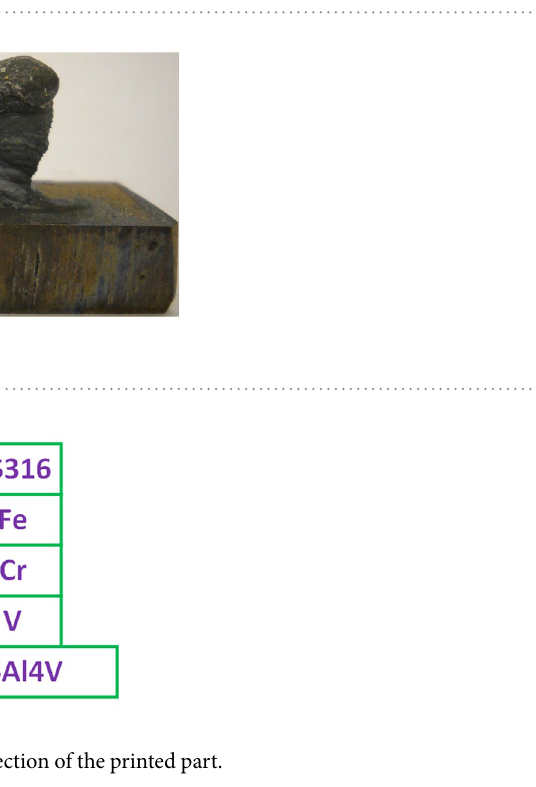
Figure 5. Vickers hardness number distribution along weld joint.